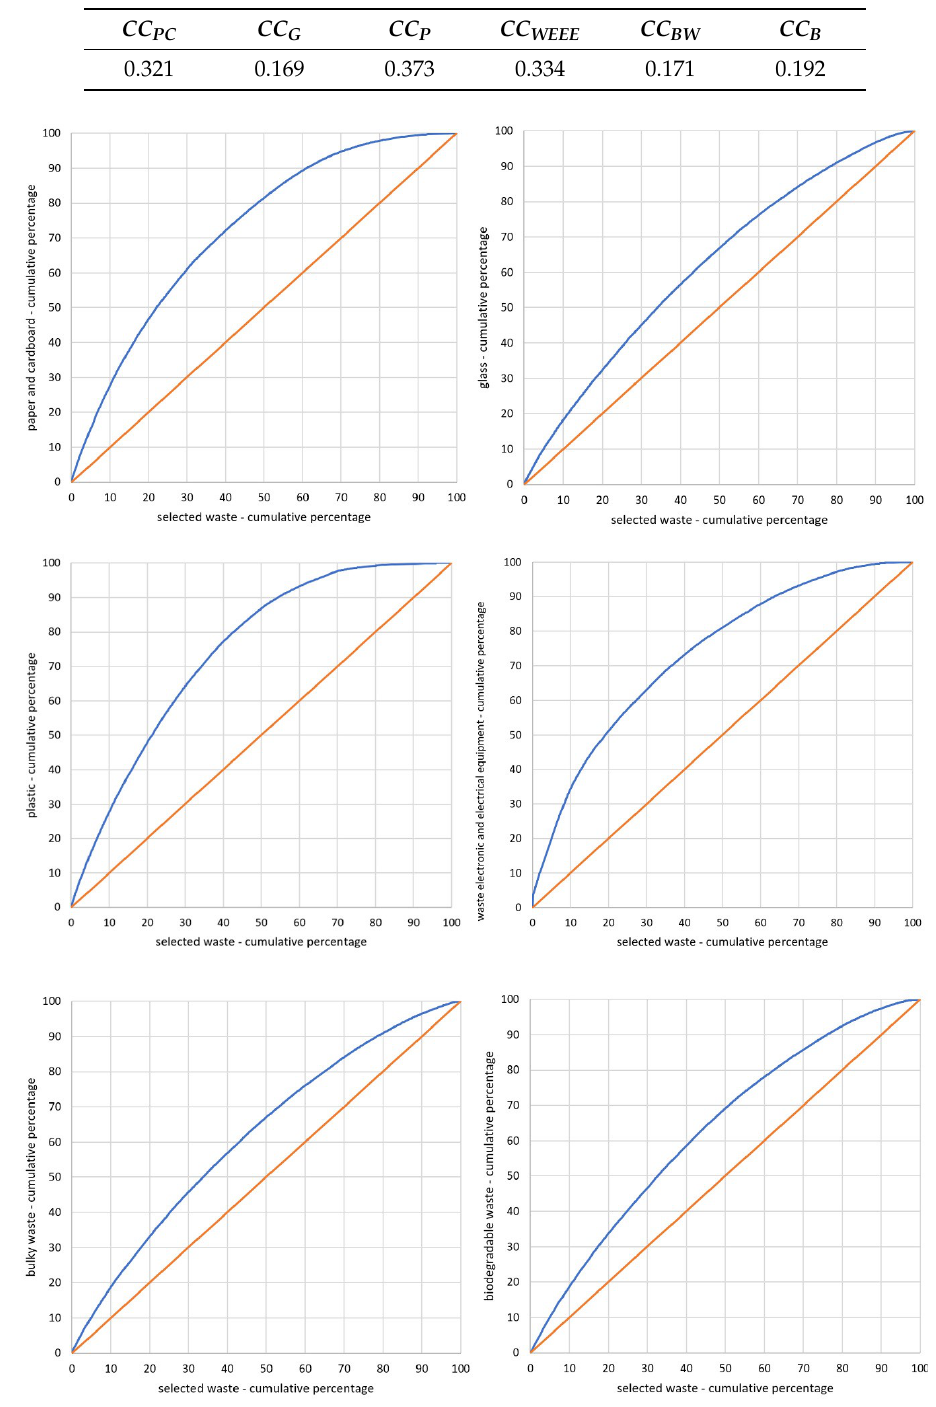
Table 1. The set of the concentration coe ffi cients ( CC ) for the analyzed selected waste fractions.